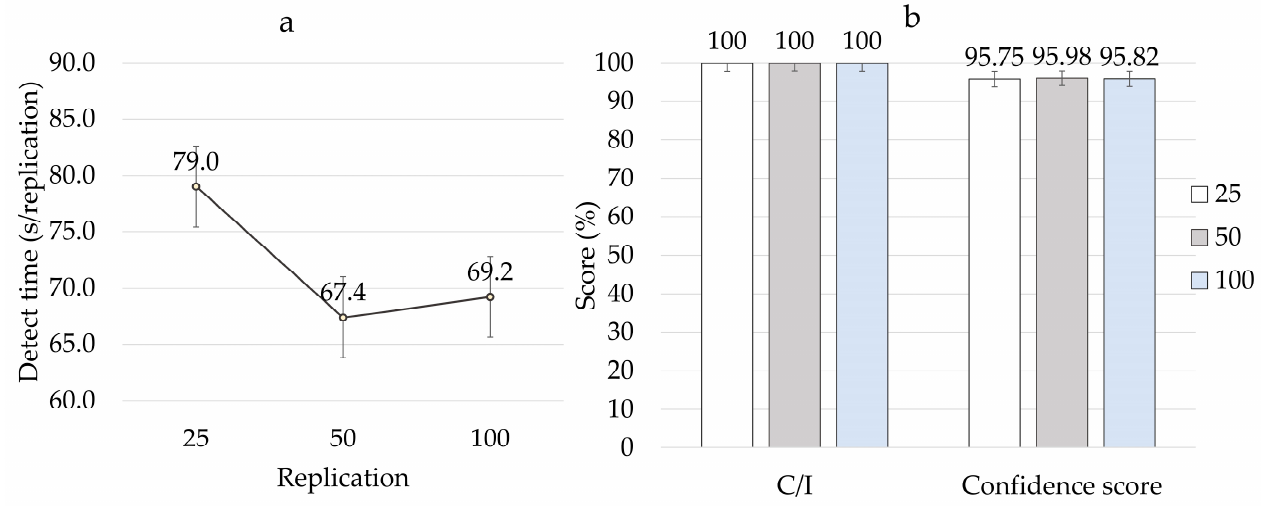
Figure 12. ( a ) A curve showing the decrease in runtime according to the number of images. ( b ) A graph indicating the C/I value of objects according to several input images of 25, 50, and 100, and the confidence score.